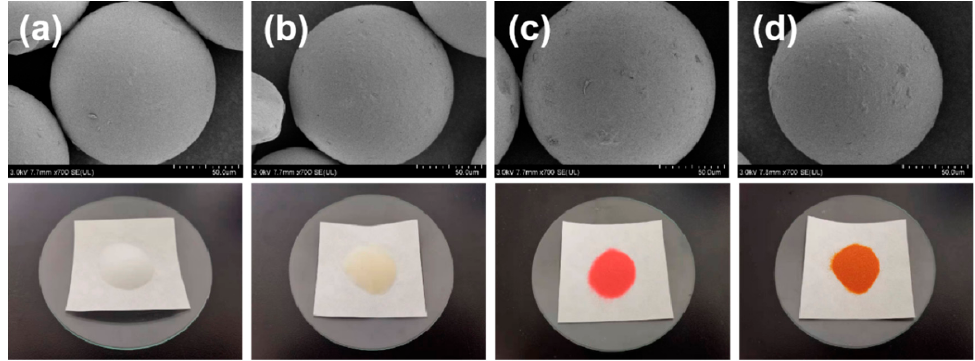
Figure 3. Appearance and SEM images of SG ( a ), SG-VTS ( b ), SG-VTS-VP ( c ) and SG-VTS-VPQ ( d ).